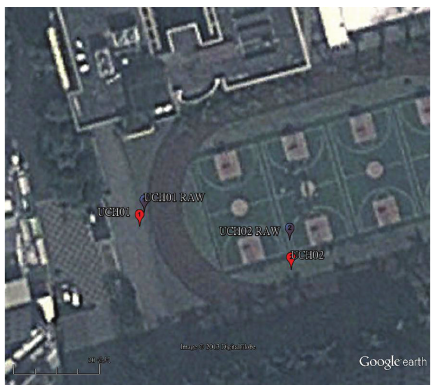
Figure 5: The image of UCH01, UCH02 and the position obtained by GPS receivers (image from Google with a proportional scale of 20 m).